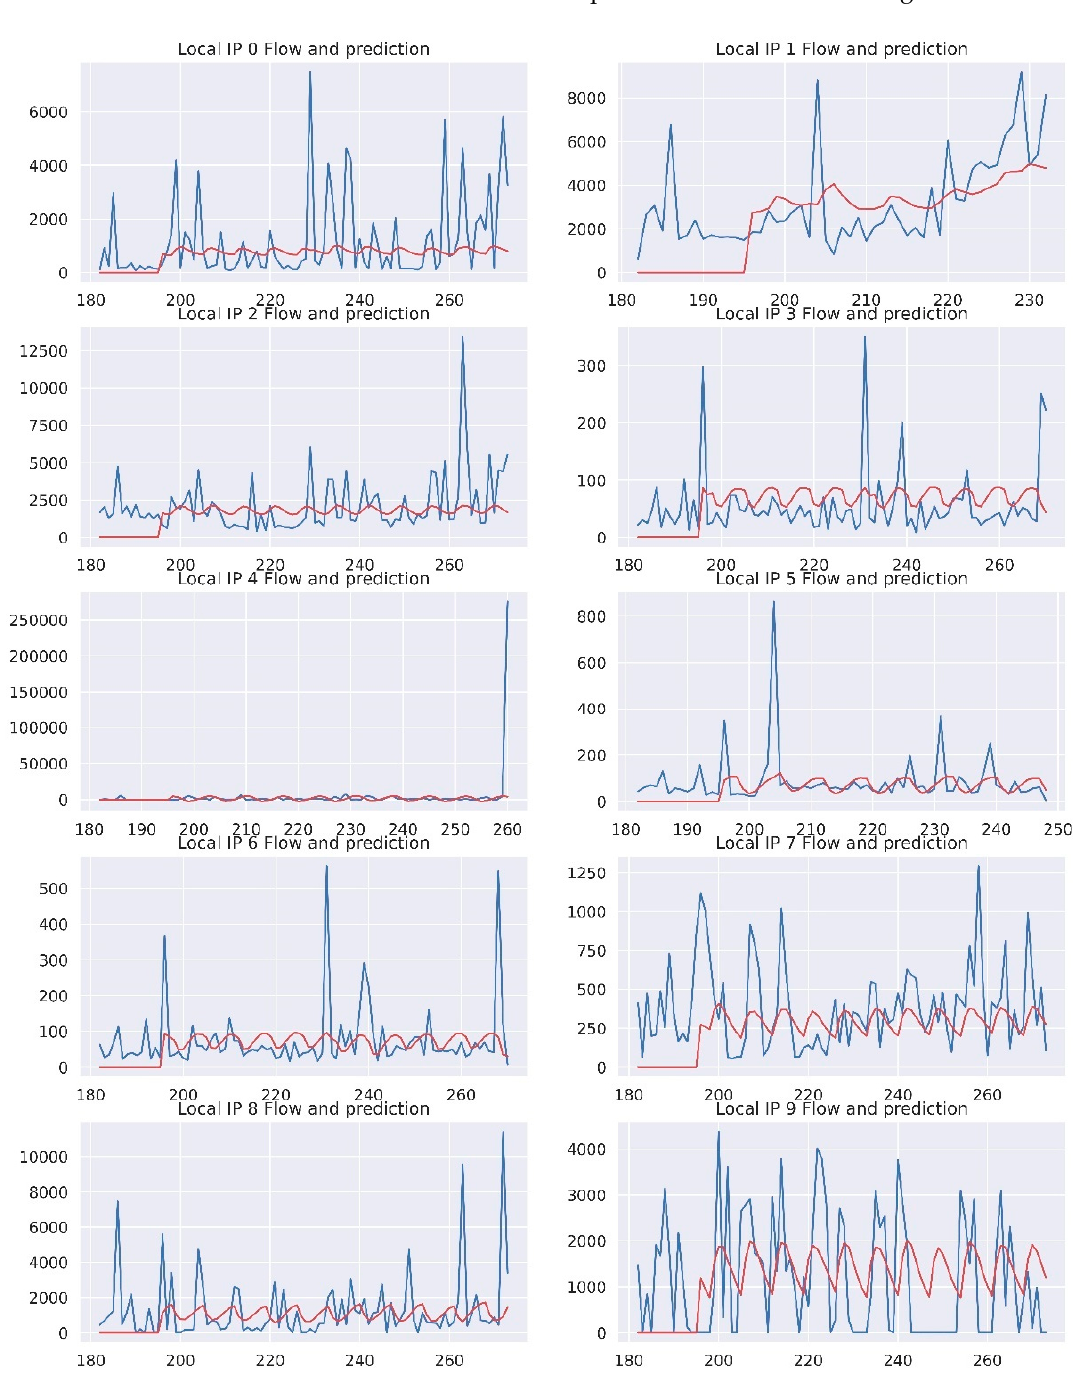
Figure 4. Developed DBoTPM model for predicting botnet attack.